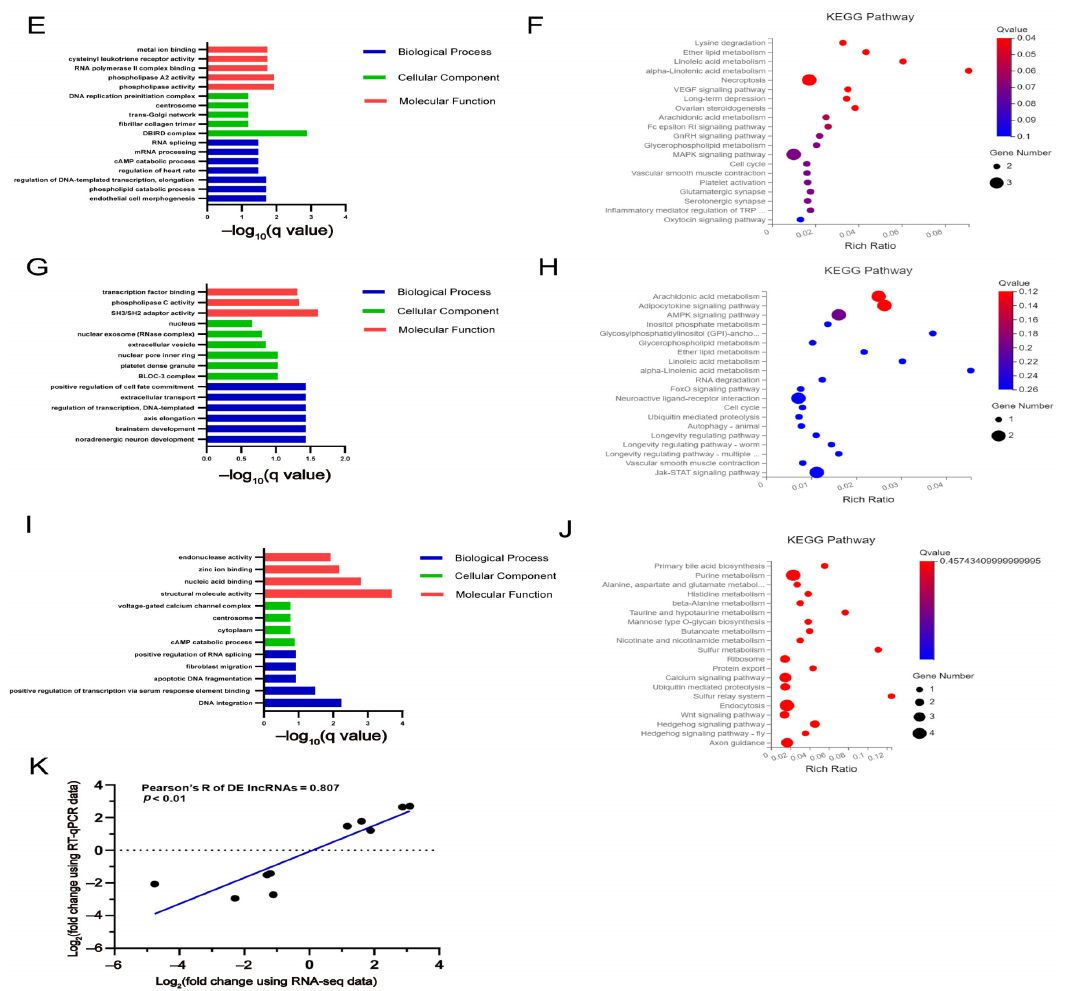
Figure 5. Expression profiles of DE lncRNAs and bioinformatic analysis of its targeted genes. ( A ) The volcano plots of the significantly differentially expressed lncRNAs at the criteria of |log 2 (foldchange)| > 1 and q value < 0.05. ( B ) Heatmap plots of the significantly differentially expressed lncRNAs. GO ( C ) and KEGG ( D ) analysis diagram of the cis target genes of DE lncRNAs upregulated in LW pigs. GO ( E ) and KEGG ( F ) analysis diagram of the cis target genes of DE lncRNAs downregulated in LW pigs. GO ( G ) and KEGG ( H ) analysis diagram of the trans target genes of DE lncRNAs upregulated in LW pigs. GO ( I ) and KEGG ( J ) analysis diagram of the trans target genes of DE lncRNAs downregulated in LW pigs. ( K ) Validation by RT-qPCR of 10 DE lncRNAs from